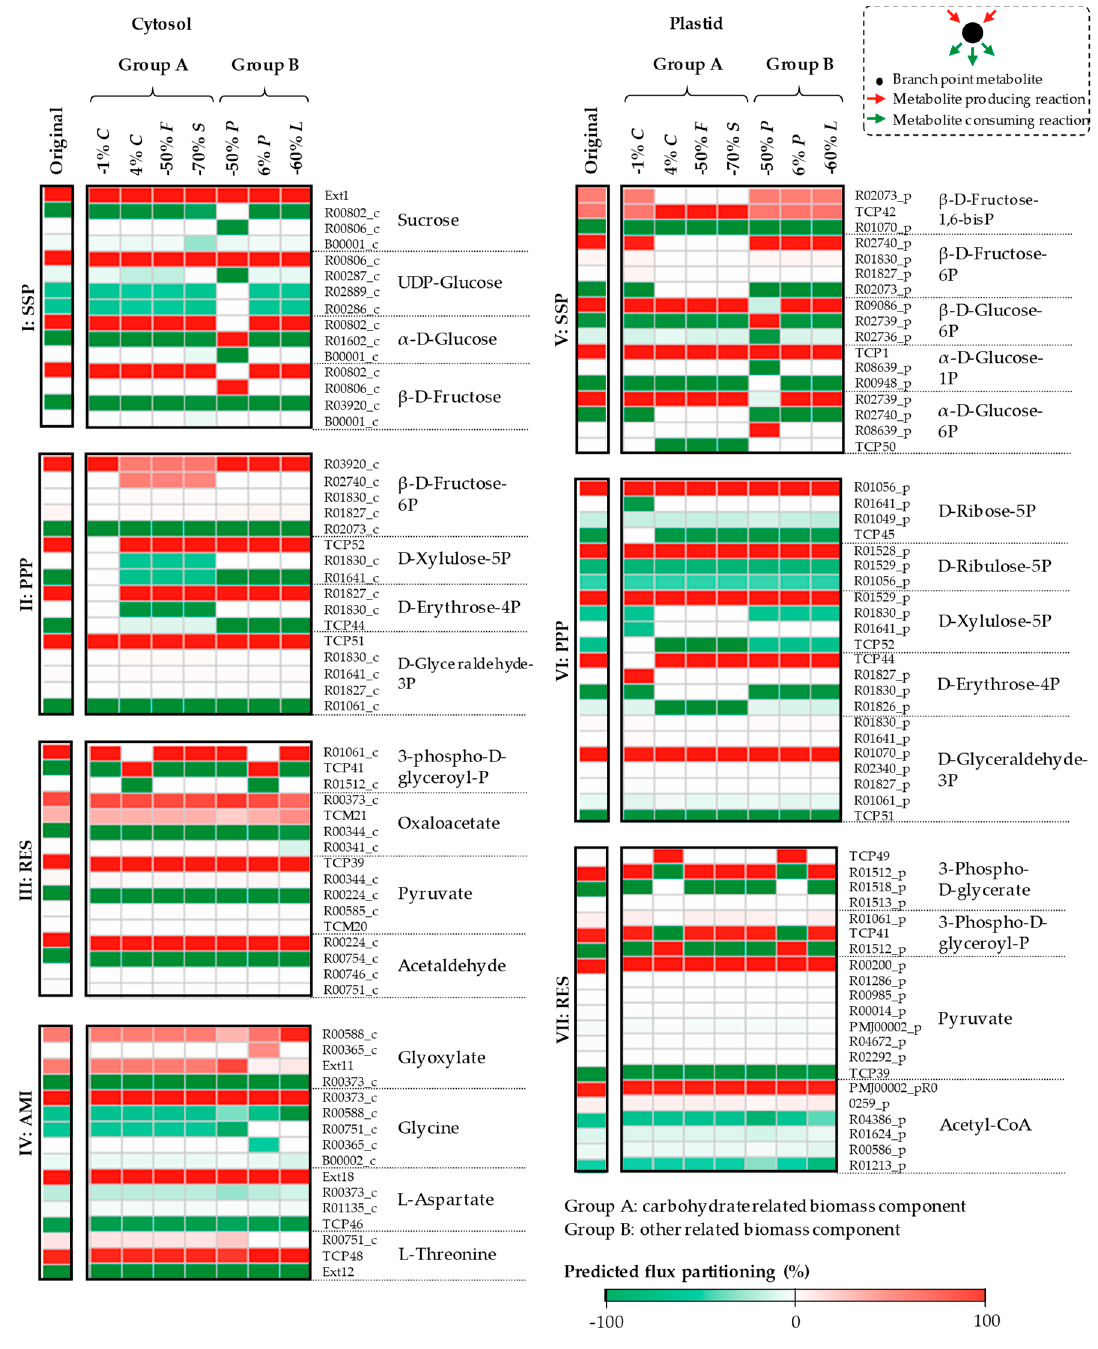
Figure 6. The influence of biomass content on flux partitioning by the rMeCBM-KU50 model. The production and consumption fluxes at each metabolic branch point were respectively denoted as positive and negative signs in the simulation. C , carbohydrate content; F , fiber content; L , lipid content; P , protein content; S , starch content; AMI, amino acid biosynthesis pathway; PPP, pentose phosphate pathway; RES, respiration pathway; SSP, starch and sucrose biosynthesis pathway.